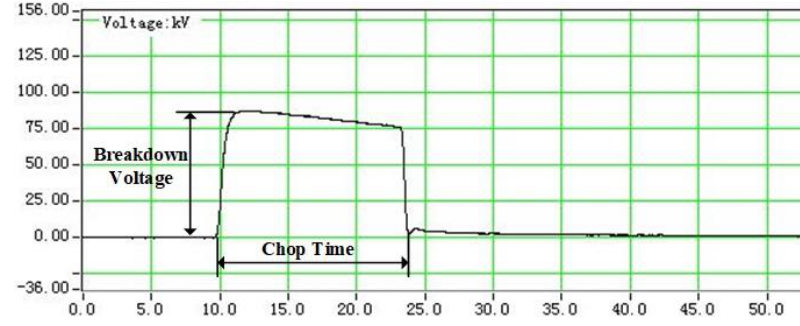
Figure 3. The breakdown voltage and chop time.